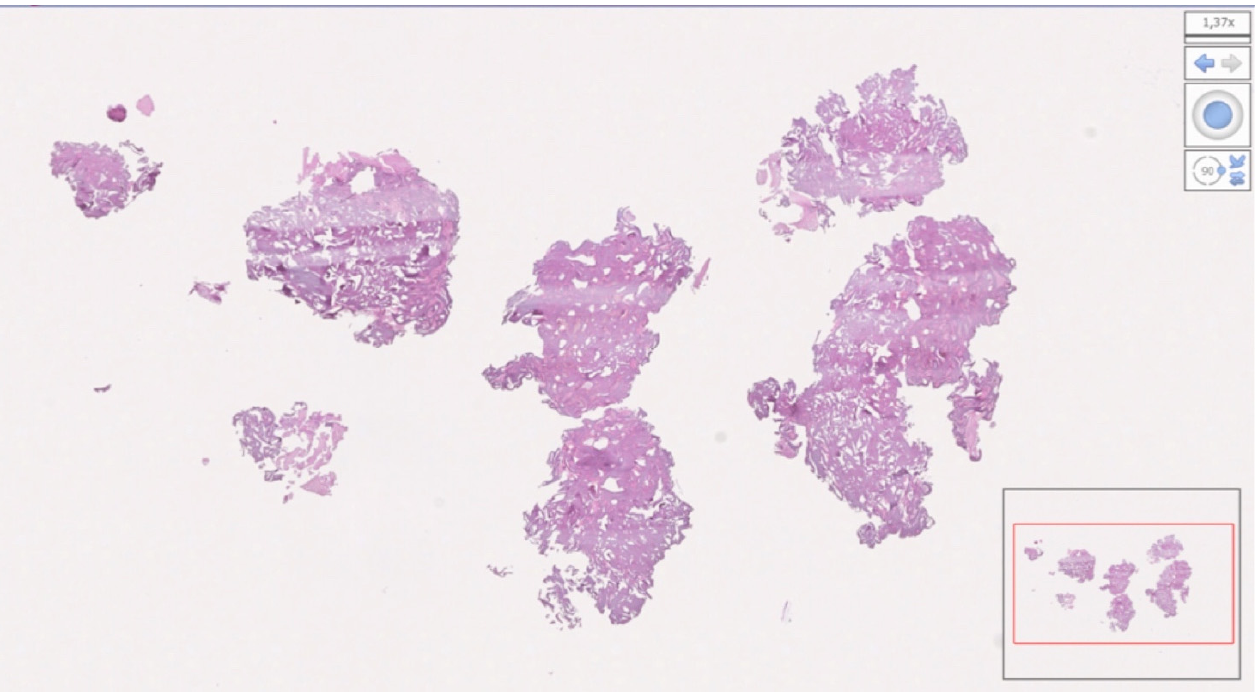
Figure 14. Bone sample taken at the upper right second molar. The patient (number 16) received L-PRF mixed with decellularized bovine compact bone from bovine femur. The sample was not assessable. Table 2. Histomorphometric analysis between groups.